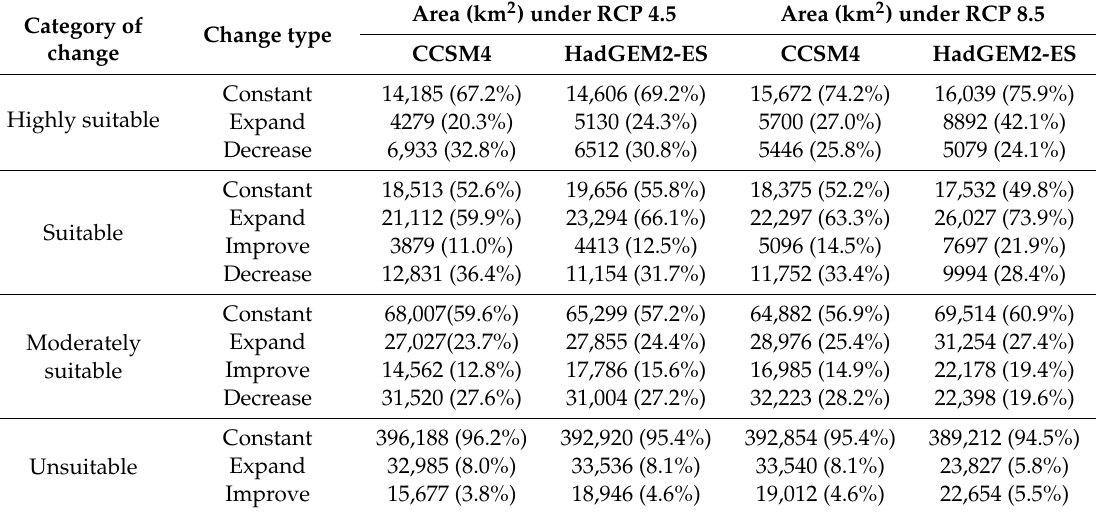
Table 5. Changes in land suitability